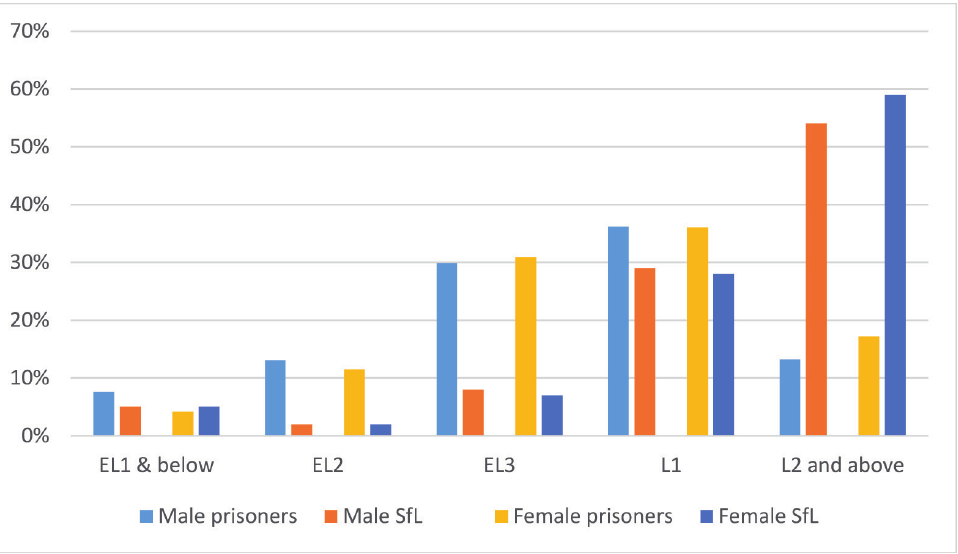
Figure 5: Prisoners’andSfL2011literacylevels,bygender